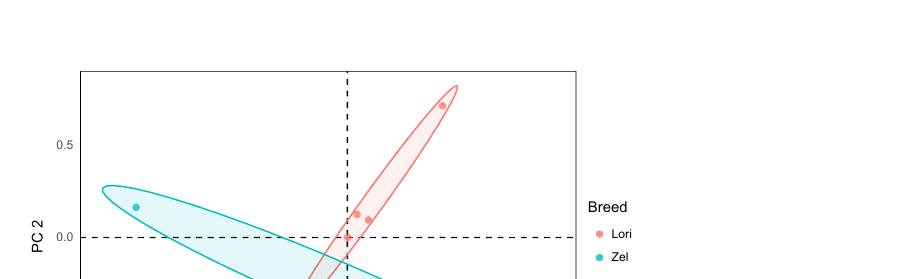
Table 1. Descriptive statistics of RNA-Seq data and alignment (number (%)).